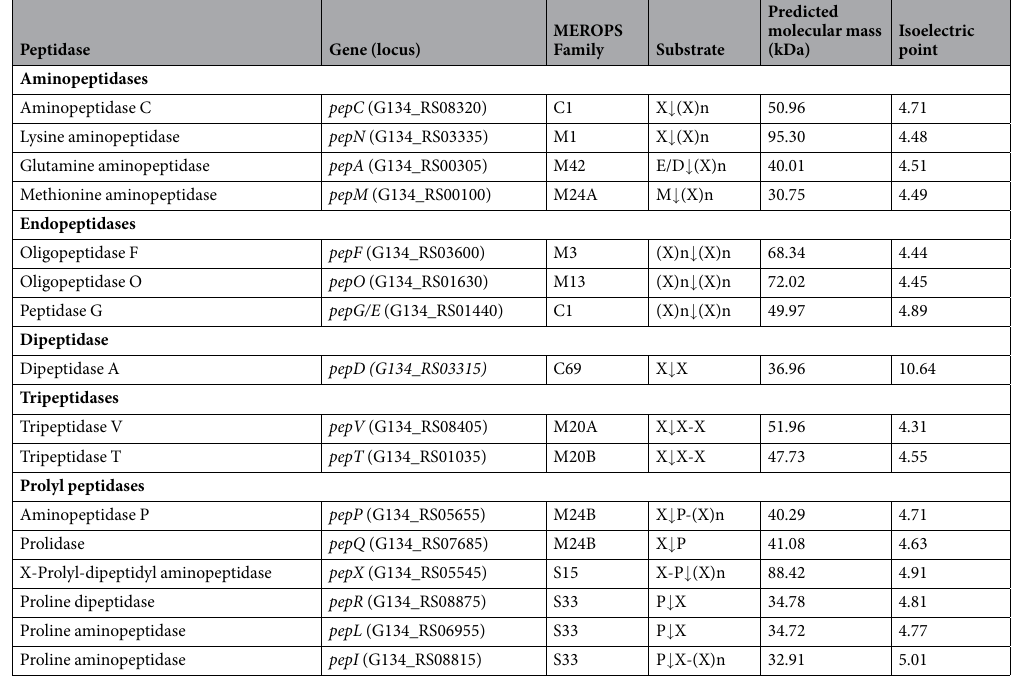
Table 1. Peptidases of the proteolytic system of L . delbrueckii subsp. lactis CRL